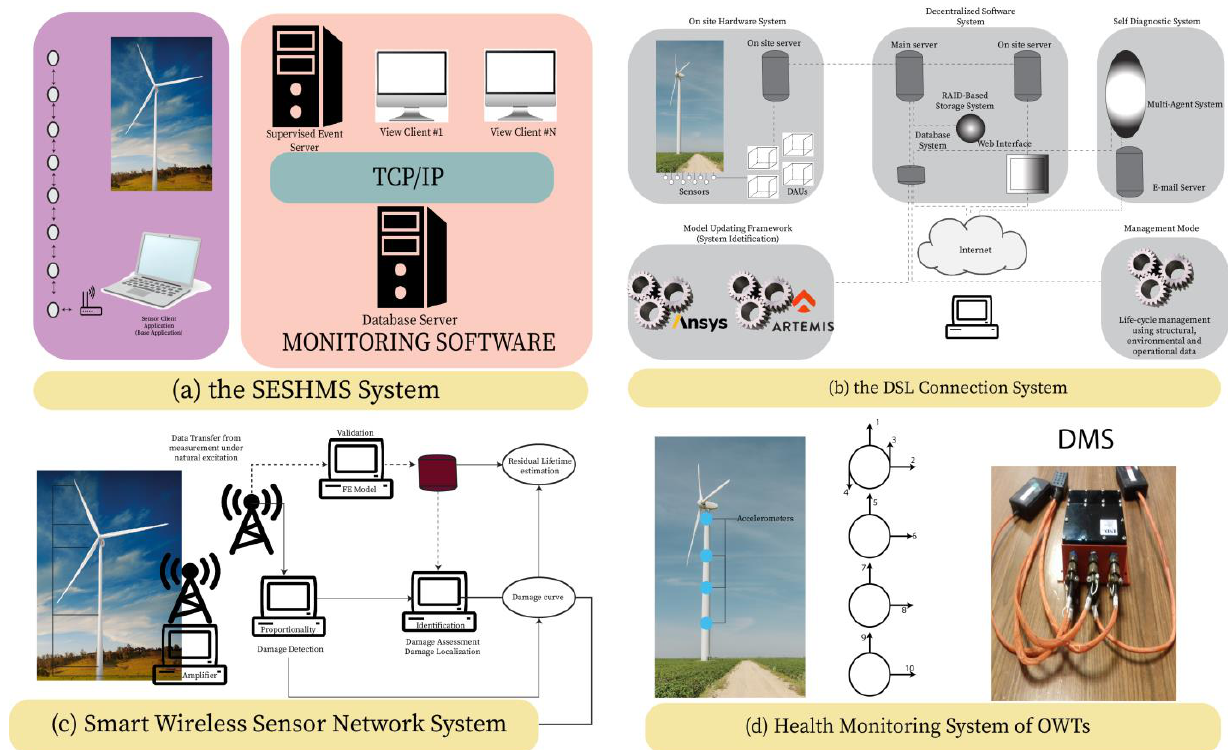
Figure 16. Health monitoring systems of wind turbines [185,189,190,192]. SESHMS: server health monitoring system; WSN: wireless sensor network; DSL: digital subscriber line; DAS: data acquisition system.